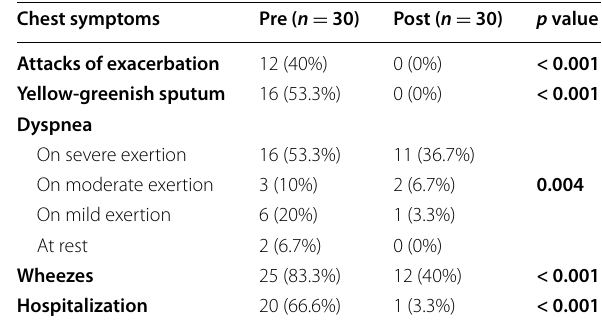
Table 3 Frequency of chest symptoms among patients before and after nutritional